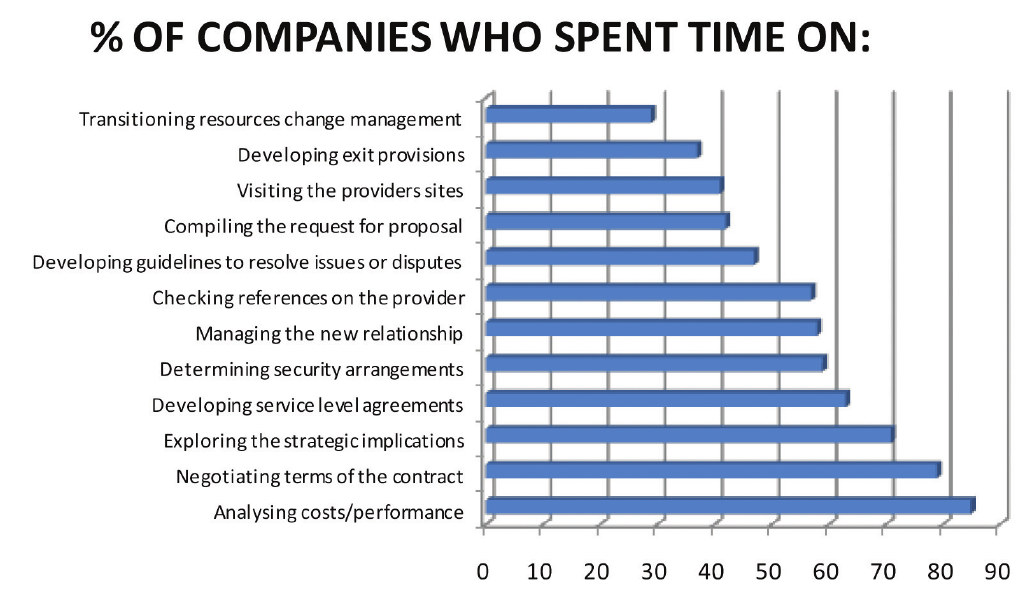
Figure 2: Time spent on outsourcing steps by respondent